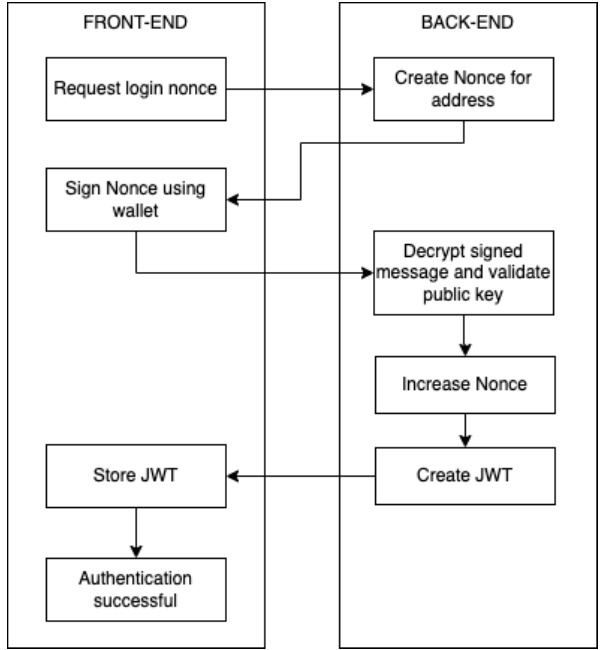
Figure 5. End to End wallet login